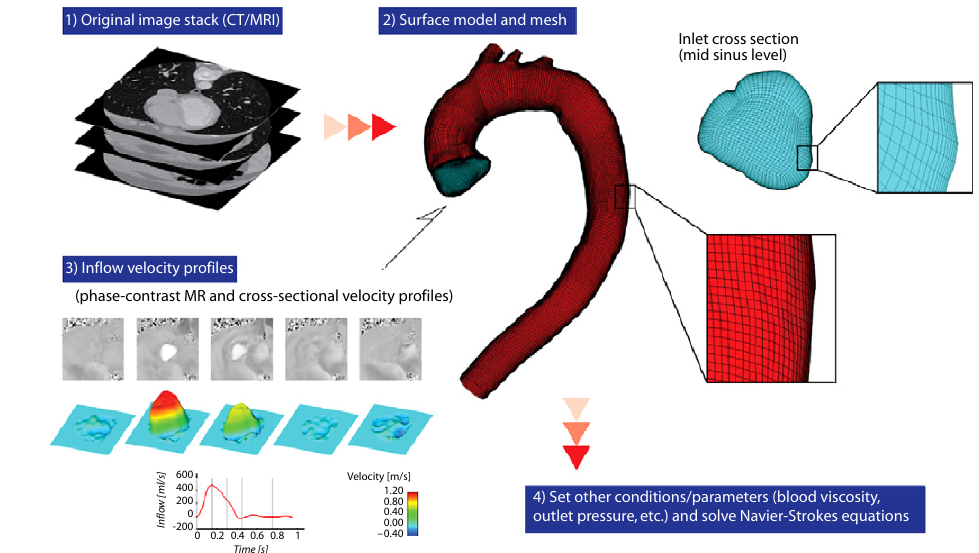
Figure. 2 Typical procedure for subject-specific blood flow computation. (A) acquisation of clinical images, (B) image segmentation and mesh generation, (C) applying boundary conditions (inflow velocity profiles at mid- sinus level in this example) and (D) setting physical properties such as blood density and viscosity, before solving the equations for fluid motion, i.e. Navier–Stokes equations. hexahedral (brick) shapes are commonly used in 3D computations. Because spatial gradients of variables in the governing equations are calculated based on the mesh, it is essential that the mesh is fine enough to resolve important features of the physical phenomena concerned. For example, blood flow velocity at the vessel wall is close to zero but it may change rapidly with the distance from the wall. Hence a fine mesh is required to capture the detailed velocity profile near the vessel